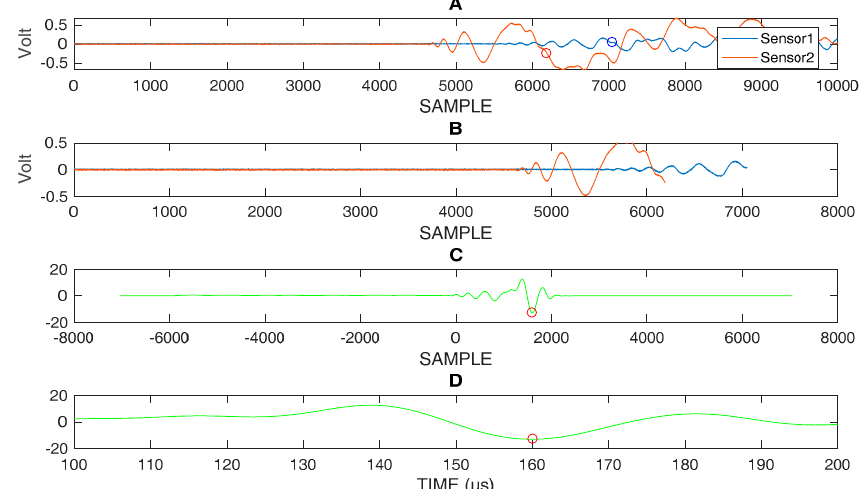
Figure 10. ( A ) impact #4: acquired signals sensor 1 and sensor 2 with marked positions by circles indicating the end of the time window used for further processing, ( B ) Selected time window, ( C ) correlation evaluated with the two selected signals shown in ( B ), ( D ) zooming of correlation in ( C ) and representation on time scale: DToA = 158 µs. Ts = 40 ns.